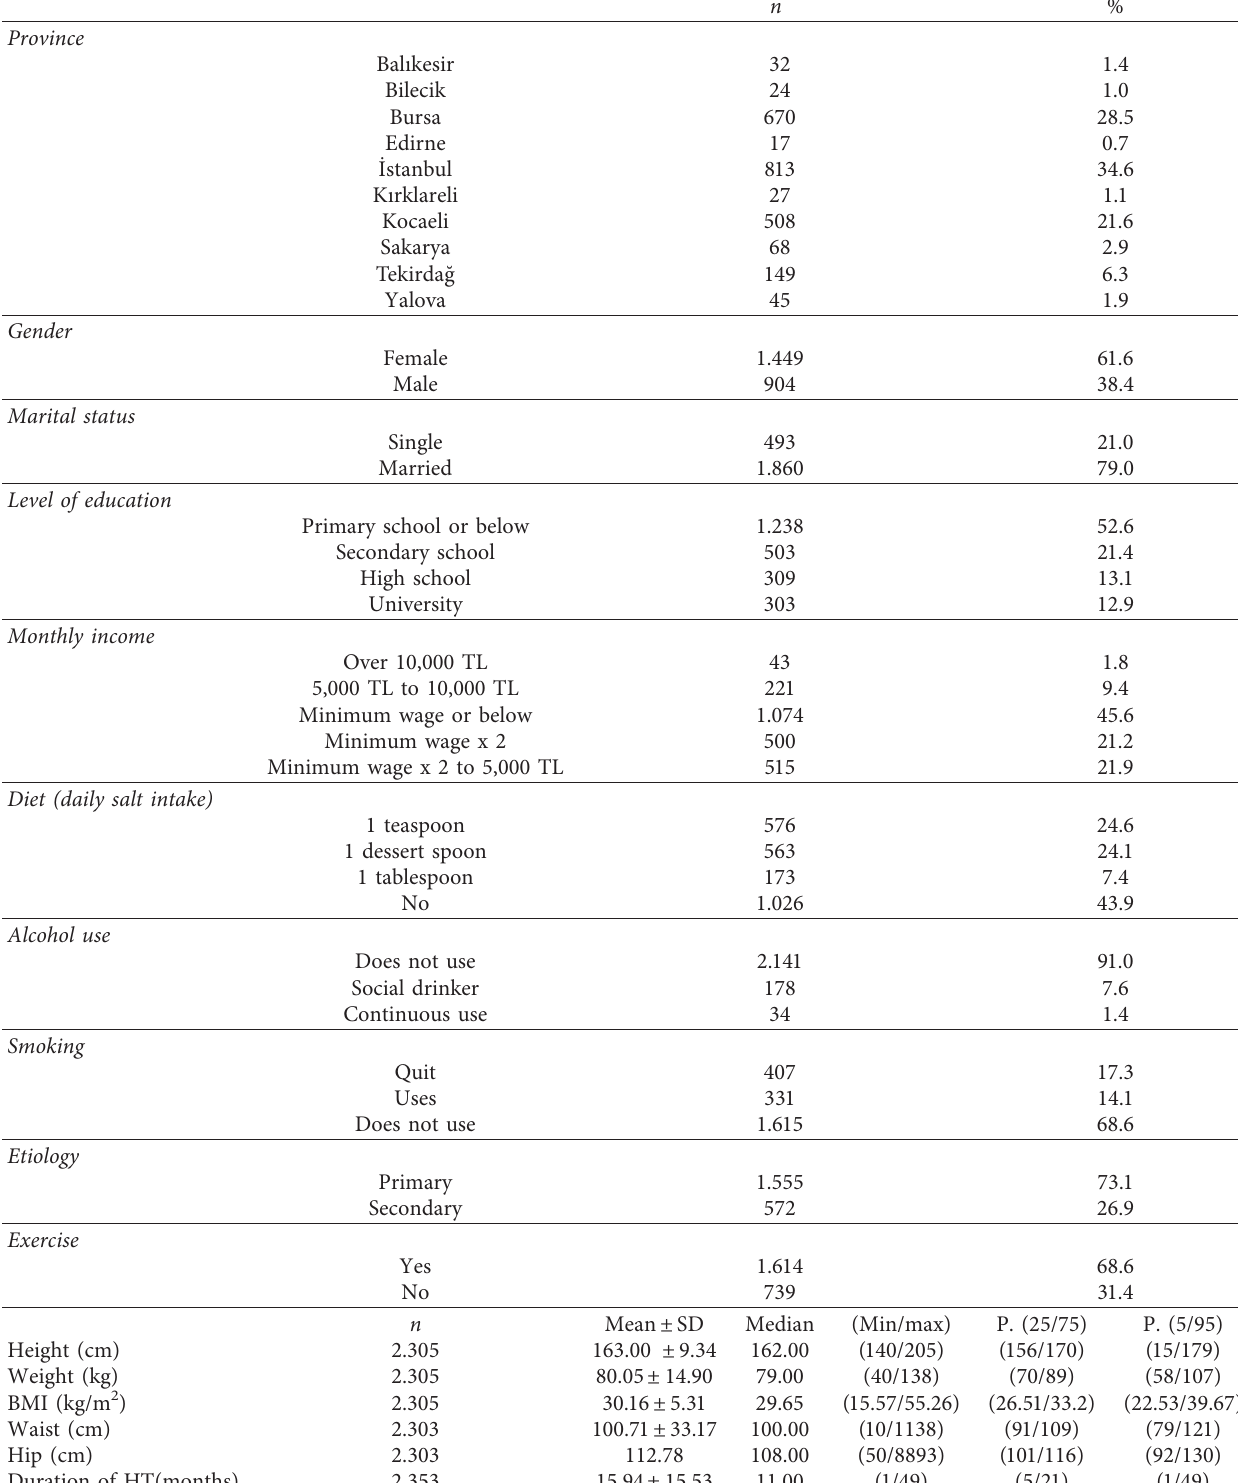
Table 1: Sociodemographic features, body measures, and duration of hypertension of the study